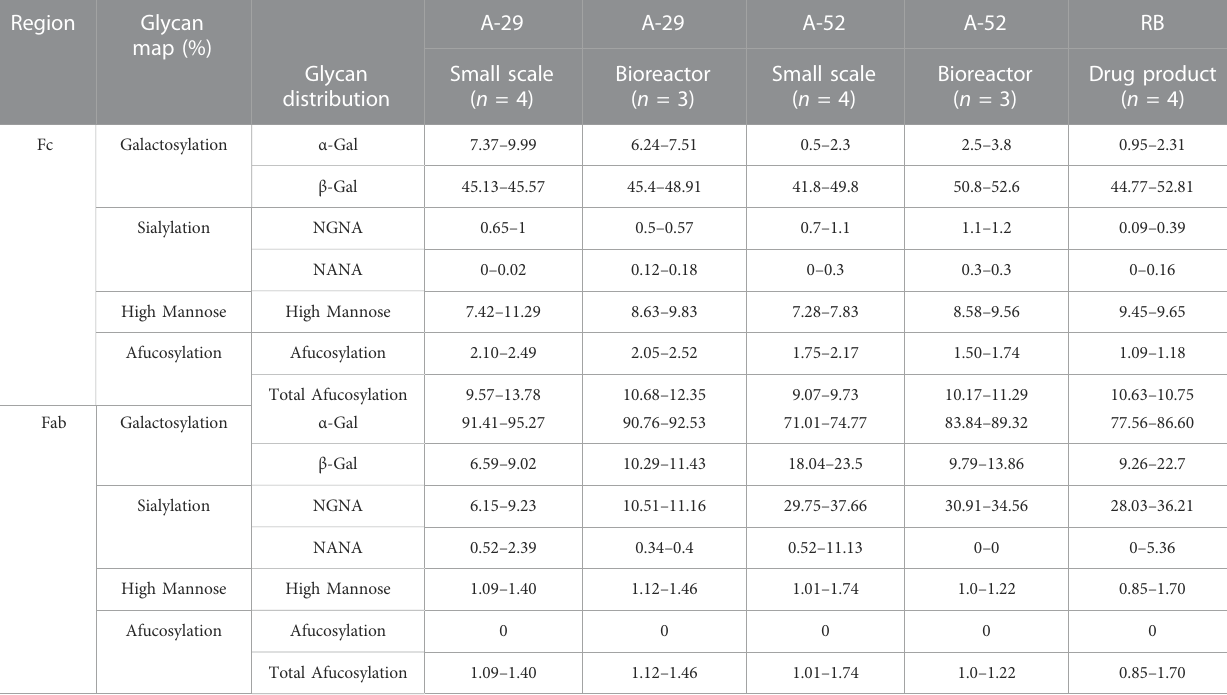
TABLE 2 LC-MS/MS analysis performed on pepsin digest of puri fi ed protein on day 10 fed-batch harvest samples for clones A-29 and A-52 for glycan analysis and molecular attributes (relative %). The Fc and Fab glycan pro fi le range of antibodies produced at small and bioreactor scale was compared with reference biologic